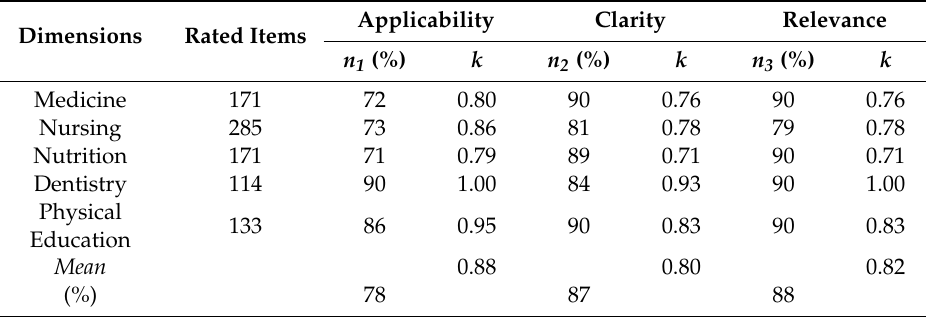
Table 4. IWHAI inter-observer Kappa coe ffi